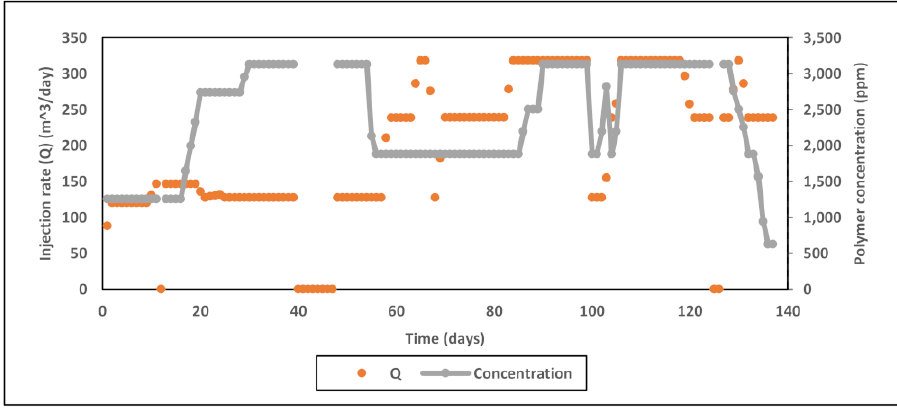
Figure 5. Data of injection rates and polymer concentrations used in the injectivity test.